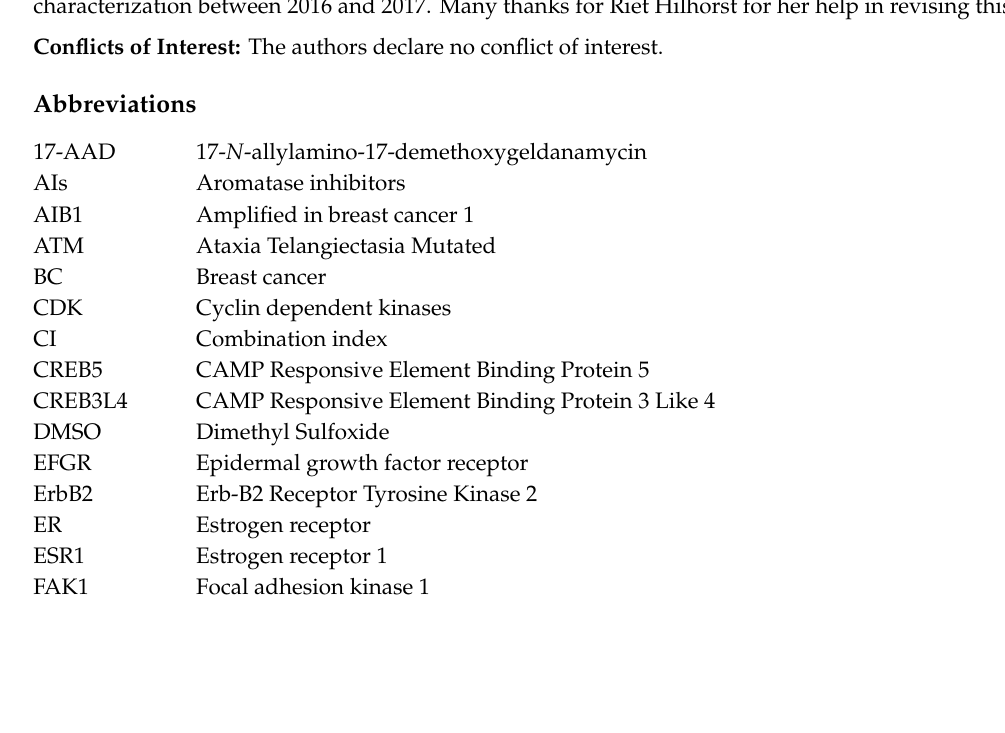
Table S2: Enrichment analysis by GO processes, Excel file S3: Breast phosphorylation by tyrosine kinase (PTK) and serine / threonine kinase (STK) data, Figure S4: Histograms of cell cycle analysis in MCF7 cells, Figure S5: Histograms showing detection of apoptosis in MCF7 cells (24